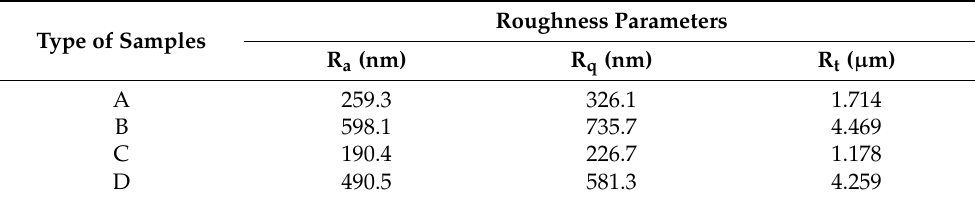
Table 4. Roughness parameters for tested samples.